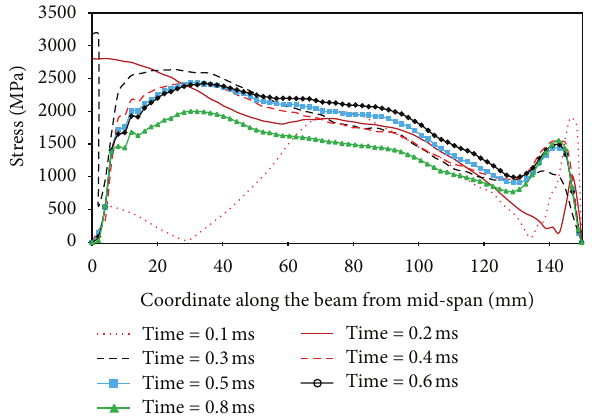
Figure 13: The stress curve of the CFRP along the beam by FEA.